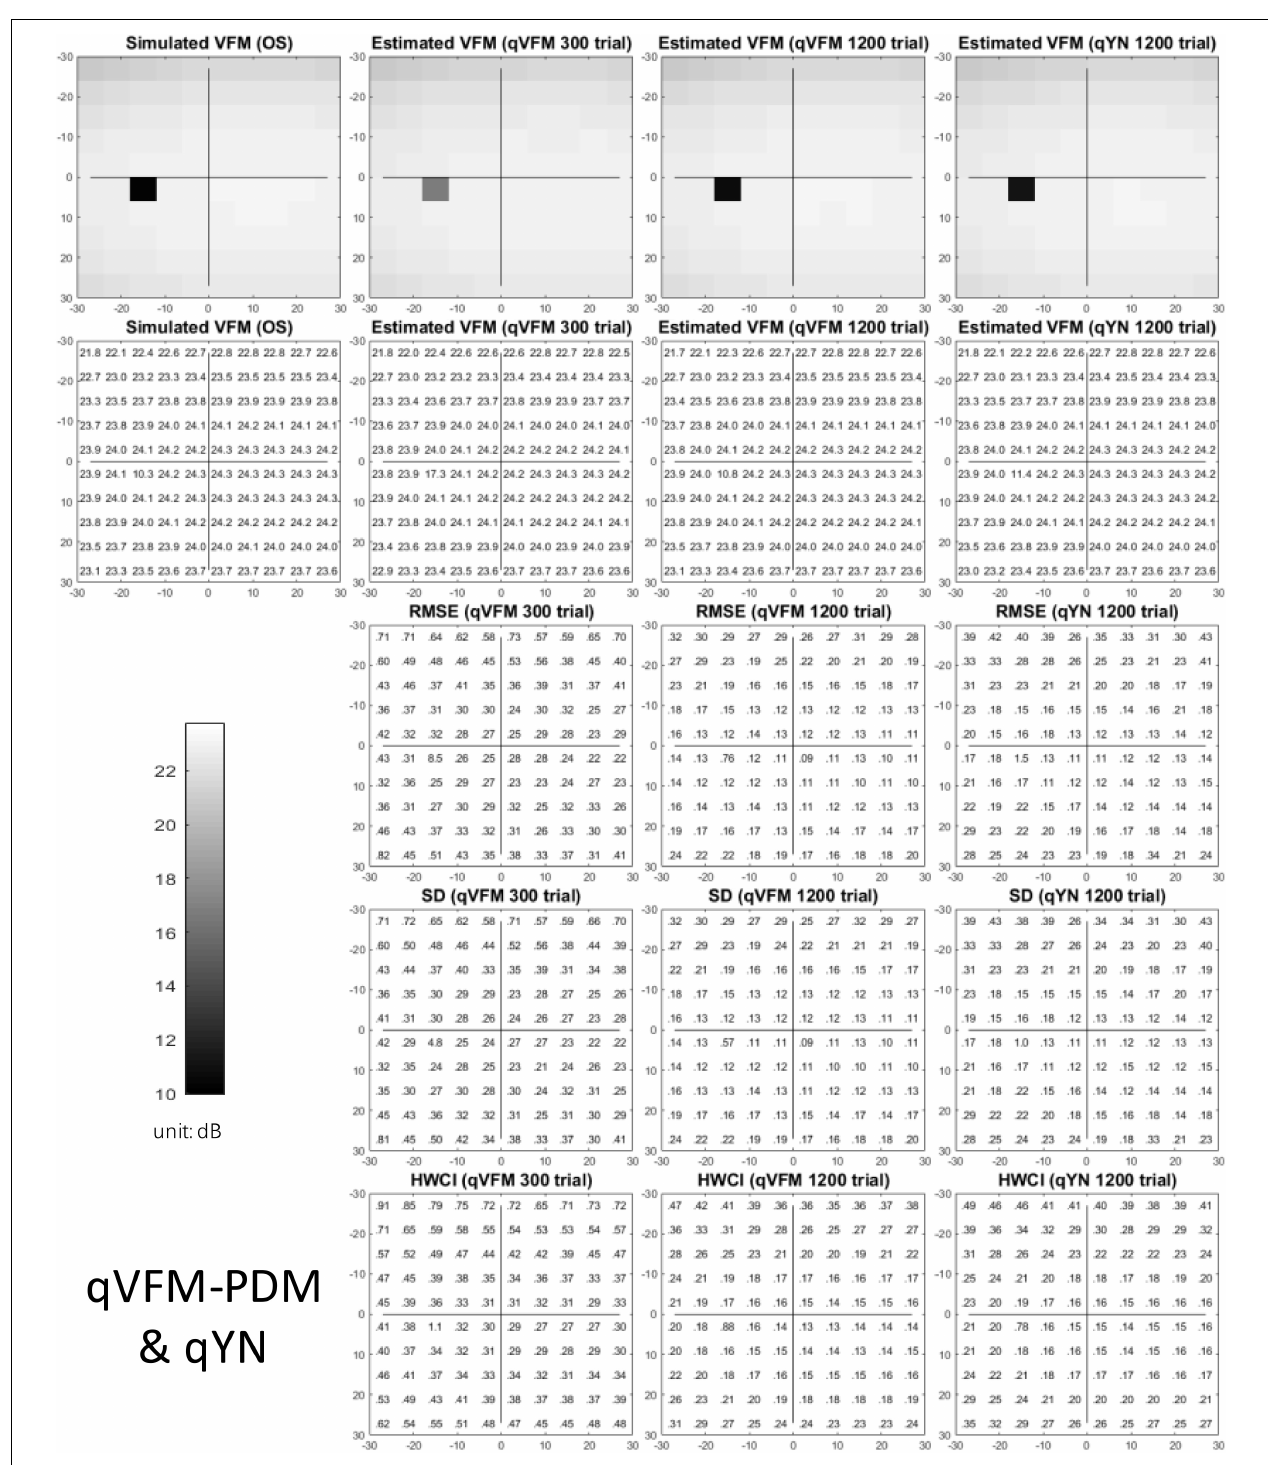
FIGURE 14 | Performance I of the qVFM-DSM, qVFM-PDM and qYN methods in estimating VFM of the simulated normal observer across 200 runs. (A) Average root mean squared error, (B) Average 68.2% HWCI of the estimated VFM, (C) Average standard deviation, (D) Average volume under the surface of the VFM (VUSVFM), (E) Mean defect, (F) Short-term fluctuation, (G) Loss variance, and (H) Corrected loss variance. Results from the qVFM-DSM and qVFM-PDM methods are shown in solid black and blue lines, and results from the qYN method are shown in dashed lines. The true values of the global indices are shown in red dotted lines. For panels (B,D) , shaded regions represent ± 1 SD of the corresponding value.